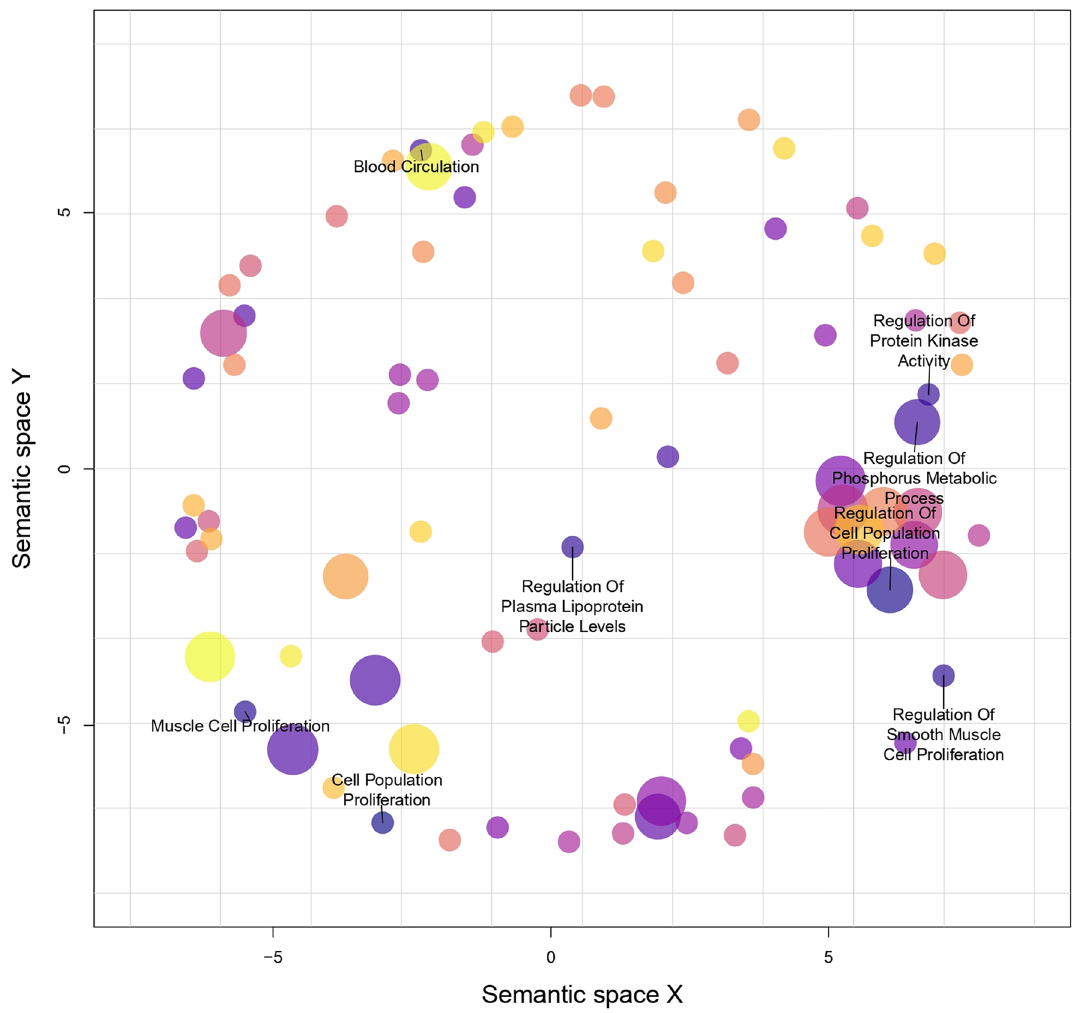
Figure 4. REVIGO Gene Ontology term clustering of 130 AAA genes. The position of each cluster within the semantic space does not matter. Semantically similar GO terms are positioned closer together in the Significant signaling networks associated with AAA SNPs. To assess the interaction between SNPs associated genes related to AAA, gene–gene interactomes were constructed and plotted using GeneMANIA plugins in Cytoscape (Fig. 5). The most significant Genes related to top 25 GO annotated functions (Table 4) were included to further grouped and visualized on the network module to see their network association accord- ing to their shared pathways, co-localization, co-expression, and physical interaction (Fig. 5A). As a hallmark of pathological remodeling in AAA, we observed the strongest interaction between TGFB1 with the TGFB1 recep- tor family and notably strong co-localization with MMP2 and MMP9 , suggesting the role of TGFB1 pathway as one of the reminiscent factors that could link the presence of SNPs to the development of AAA. This analysis also includes several additional genes predicted to convey a strong interaction with some of our gene candidates. 14 genes were associated with lipid metabolism pathways; regulation of plasma lipoprotein level, regulation of lipid localization, regulation of lipid transport, and regulation of cholesterol transport (Fig. 5B). 10 genes were associated with extracellular matrix (ECM) organization (Fig. 5C). 11 genes were associated with smooth muscle cell proliferation pathways (Fig. 5D). 10 genes were associated with reactive oxygen species metabolism (Fig. 5E). IL-6, TGFB1, and TGFB1 receptor family shared three modules, the most out of all genes. IL-6 is involved in lipid metabolism, ECM organization, and smooth muscle cell proliferation pathways. While TGFB1 and the TGFB1 receptor family are involved in ECM organization, smooth muscle cell proliferation, and ROS metabolism pathways. Clinical characteristics of AAA patients. Out of the AAA candidate gene association studies in the literature, we found 15 studies with complete clinical data, totaling a sample size of 10.956 (5676 control & 5280 case). The available clinical data were age (mean), men (n), aortic diameter (mm, mean), smoking (current & past), hypertension, diabetes, CAD (coronary artery disease), PAD (Peripheral Artery Disease), and dyslipi-